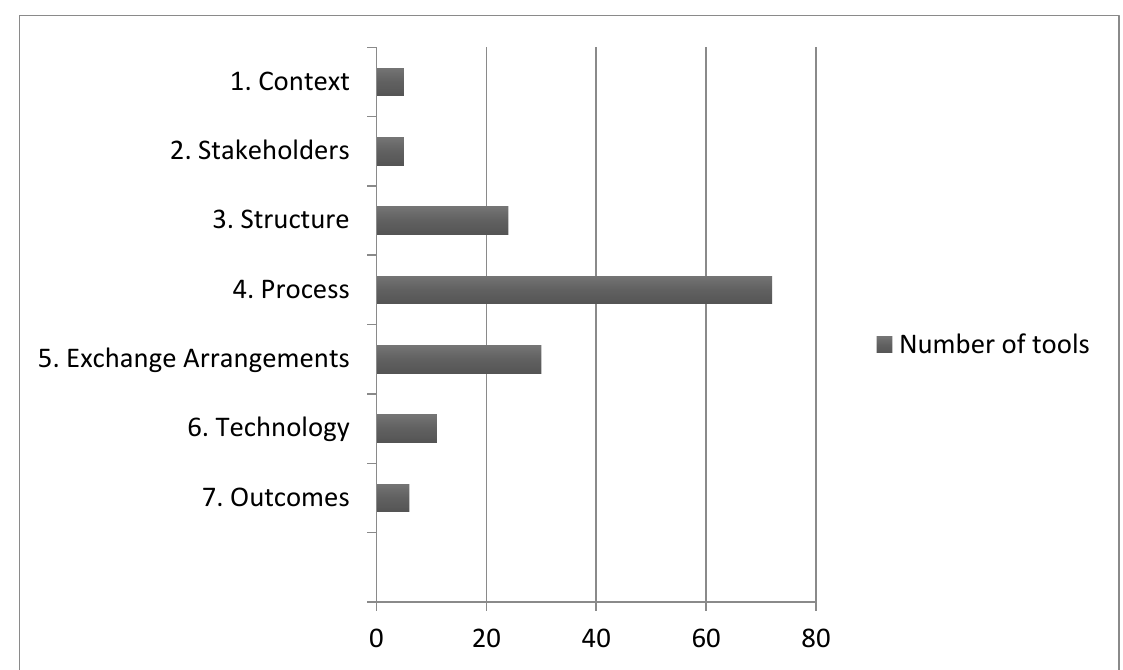
Figure 6. Number of tools found for smart governance categories.